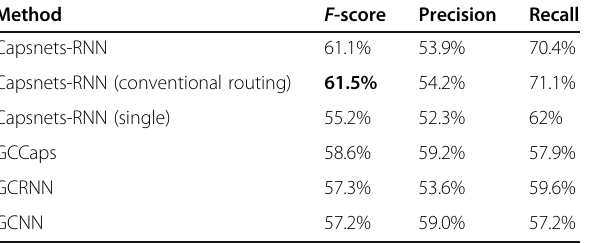
Table 4 Performance results of audio tagging subtask